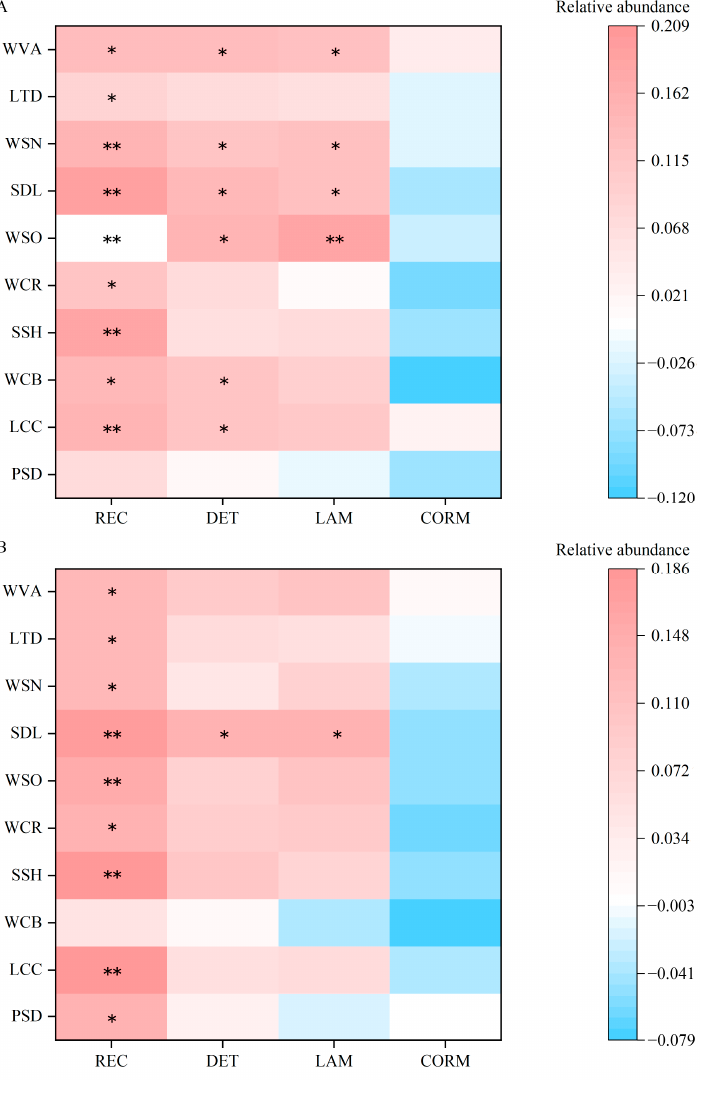
Figure 10. Correlation between visual behavior coincidence and cognitive evaluation. This figure was created by the author. Note: ( A ) The first viewing, ( B ) The second viewing. * significant correlation with p < 0.050, ** significant correlation with p < 0.010. The analysis and graphics software are Origin Pro 2021 v9.8.0.200. This figure was created by the author.